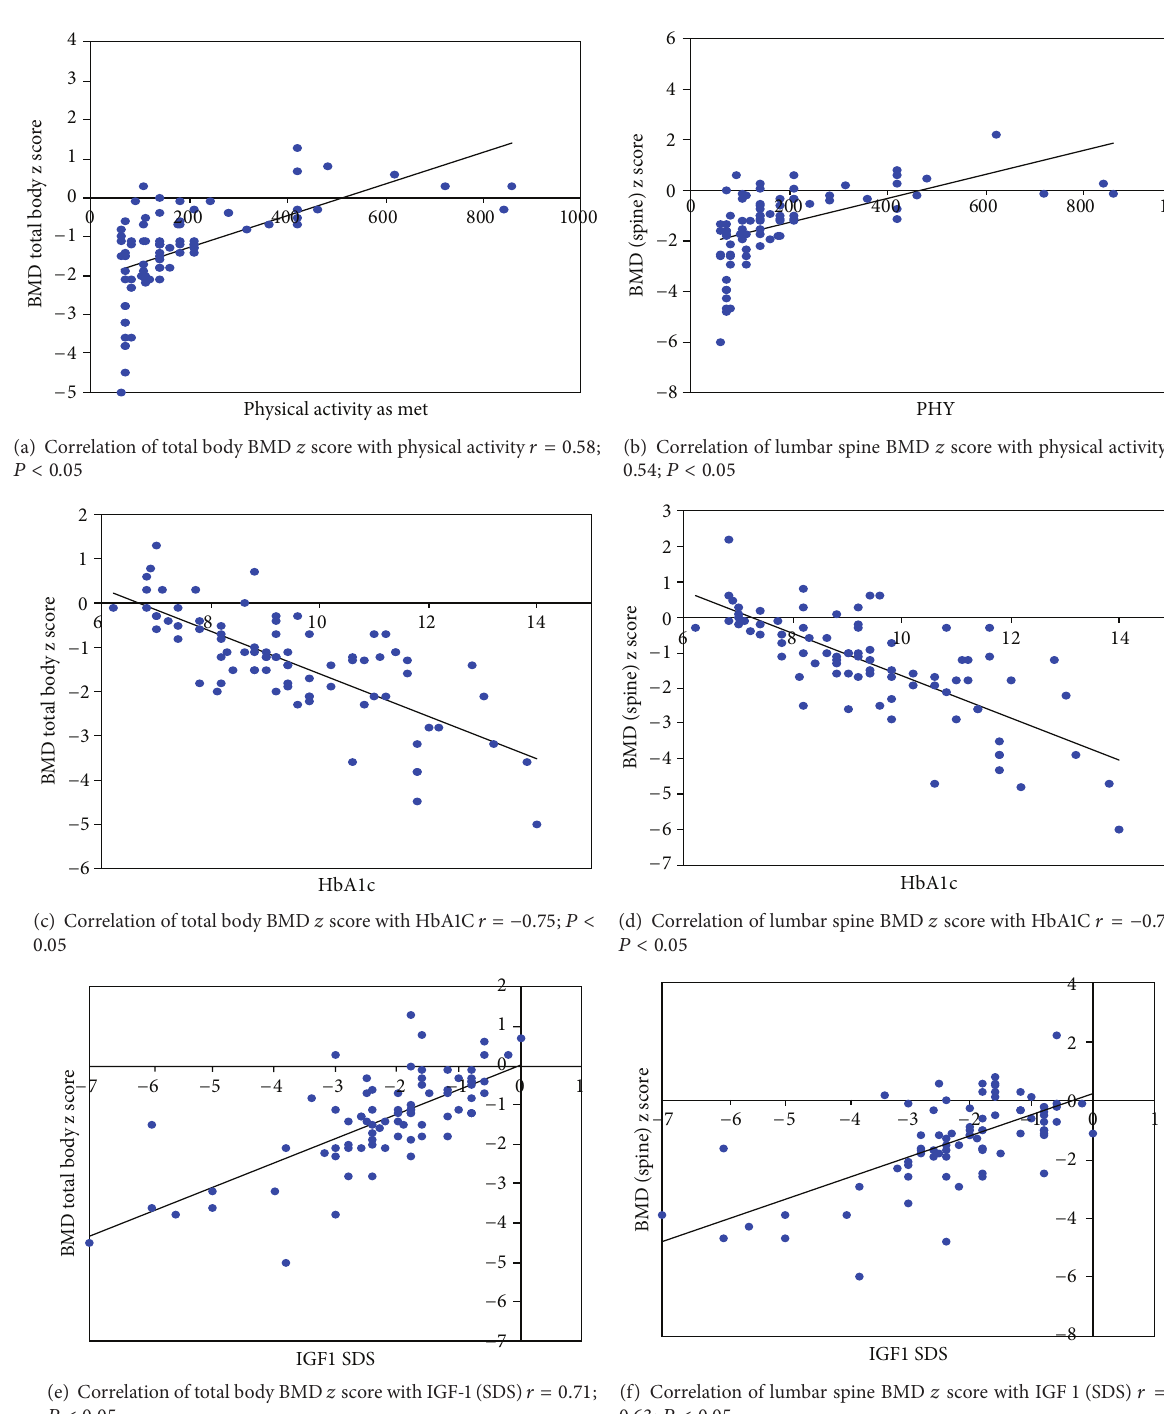
(e) Correlation of total body BMD 𝑧 score with IGF-1 (SDS) 𝑟 = 0.71 ; (f) Correlation of lumbar spine BMD 𝑧 score with IGF 1 (SDS) 𝑟 = 𝑃 < 0.05 0.63 ; 𝑃 < 0.05 Figure 1: Correlation curves with coefficients of total body and lumbar spine BMD 𝑧 score with physical activity as metabolic equivalent time (MET), glycated haemoglobin (HbA1c), and insulin-like growth factor-1 (IGF-1) standard deviation score